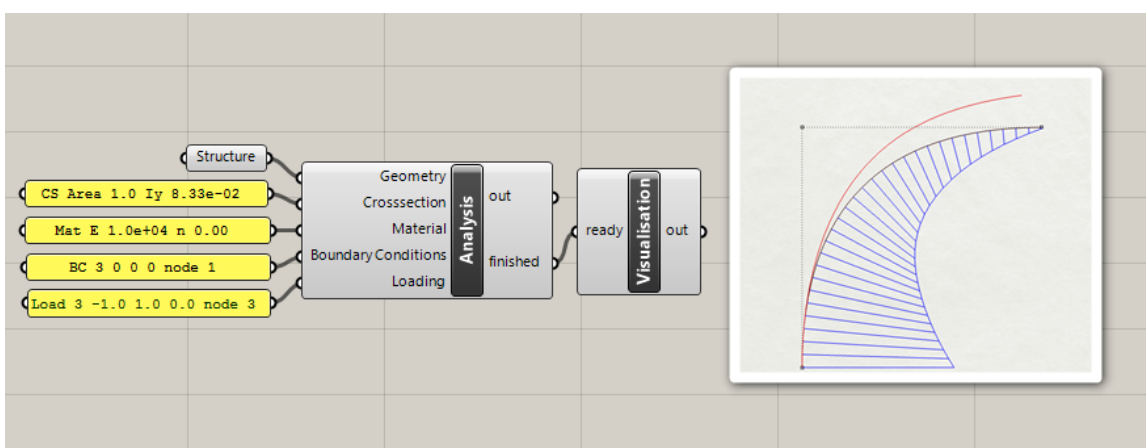
Figure 3. Schematic illustration of Grasshopper environment with results visualized in Rhino. The example corresponds to a cantilever circular arc beam (black) subjected to horizontal and vertical load at its tip. The deformed geometry is in red and the bending moment is in